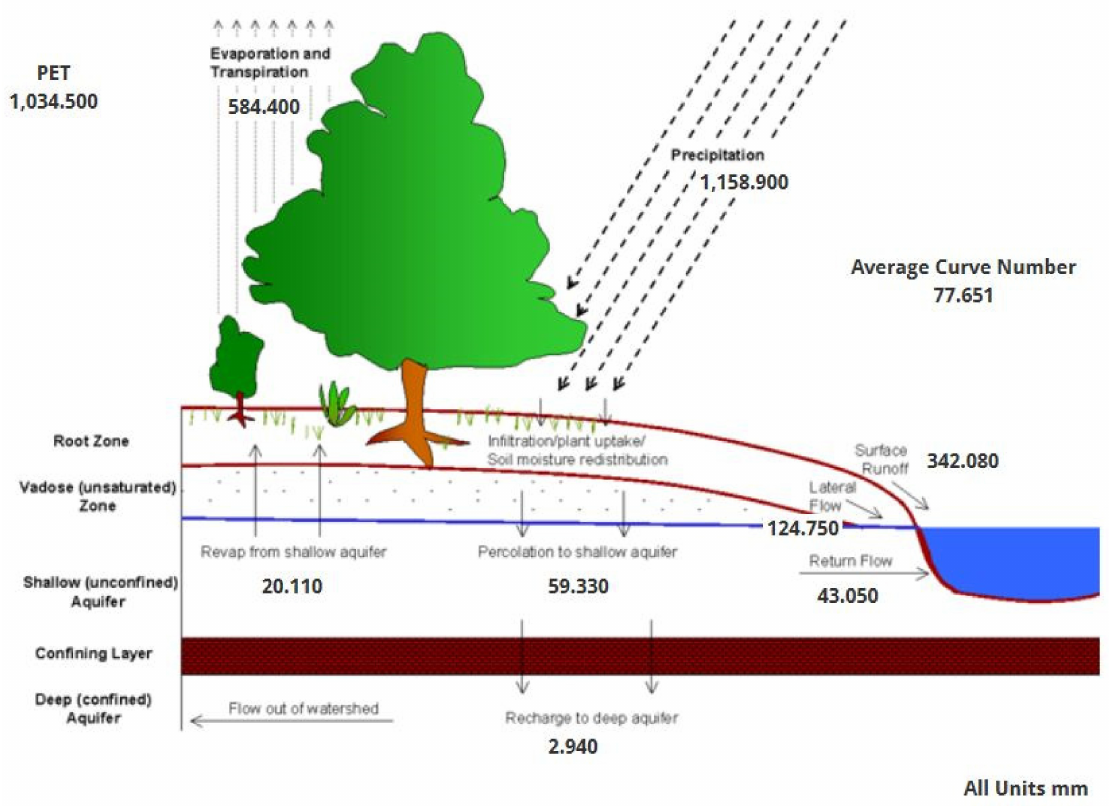
Figure A1. SWAT Check results displaying the overall hydrologic budget of the James River watershed [13].